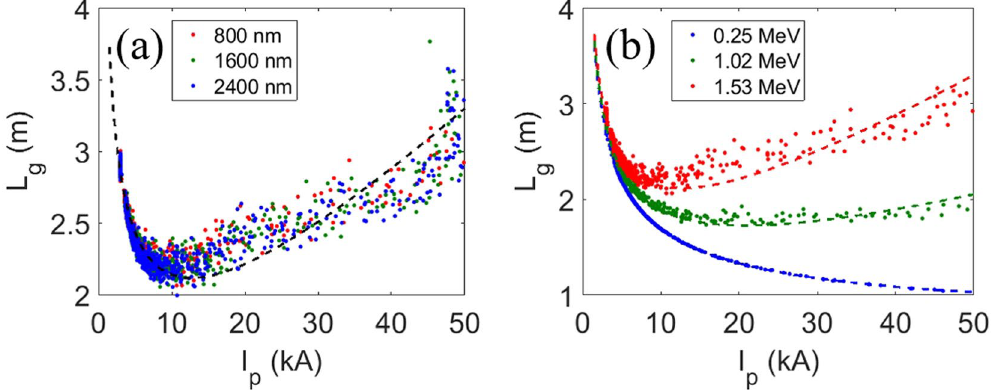
Figure 3. The 3D gain length with respect to the peak current for ( a ) different modulation laser wavelengths for a base SES of 1.53 MeV, and ( b ) different SESs of the base electron beam. Dashed lines: Eq. (3) with linear fitting result from Fig. 2 for the rms SES σ E